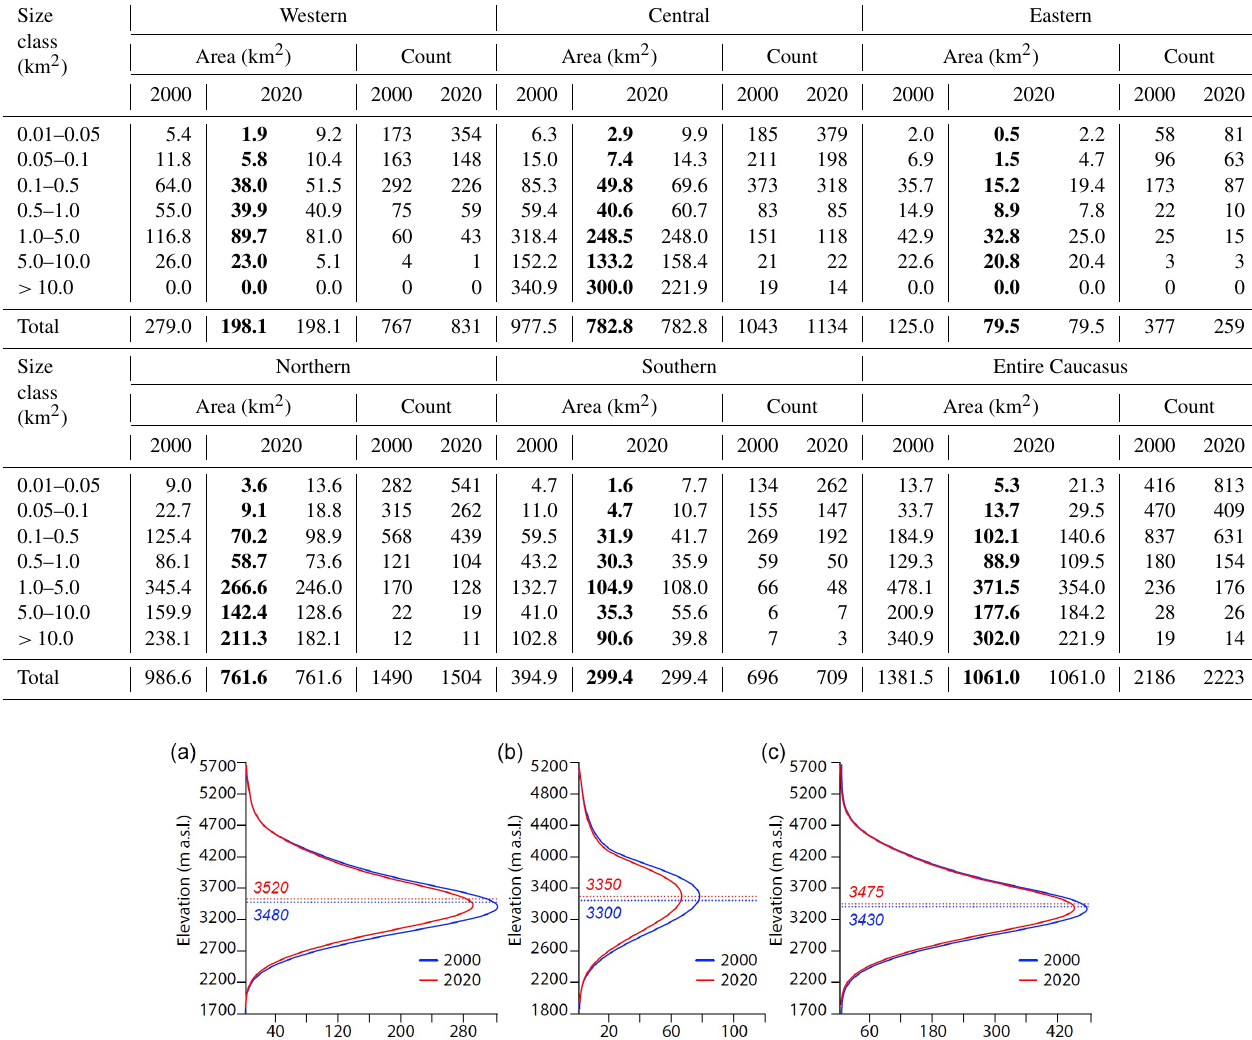
Table 2. Cumulative glacier area and count change for seven size classes in the Greater Caucasus by slope and section in 2000–2020. Bold numbers indicate the initial size class of glaciers in 2020 to fairly determine the decrease in area per size class between 2000 and 2020, while the other numbers show the absolute glacier area and count in 2020 by the same size classes (see also Fig. 9).